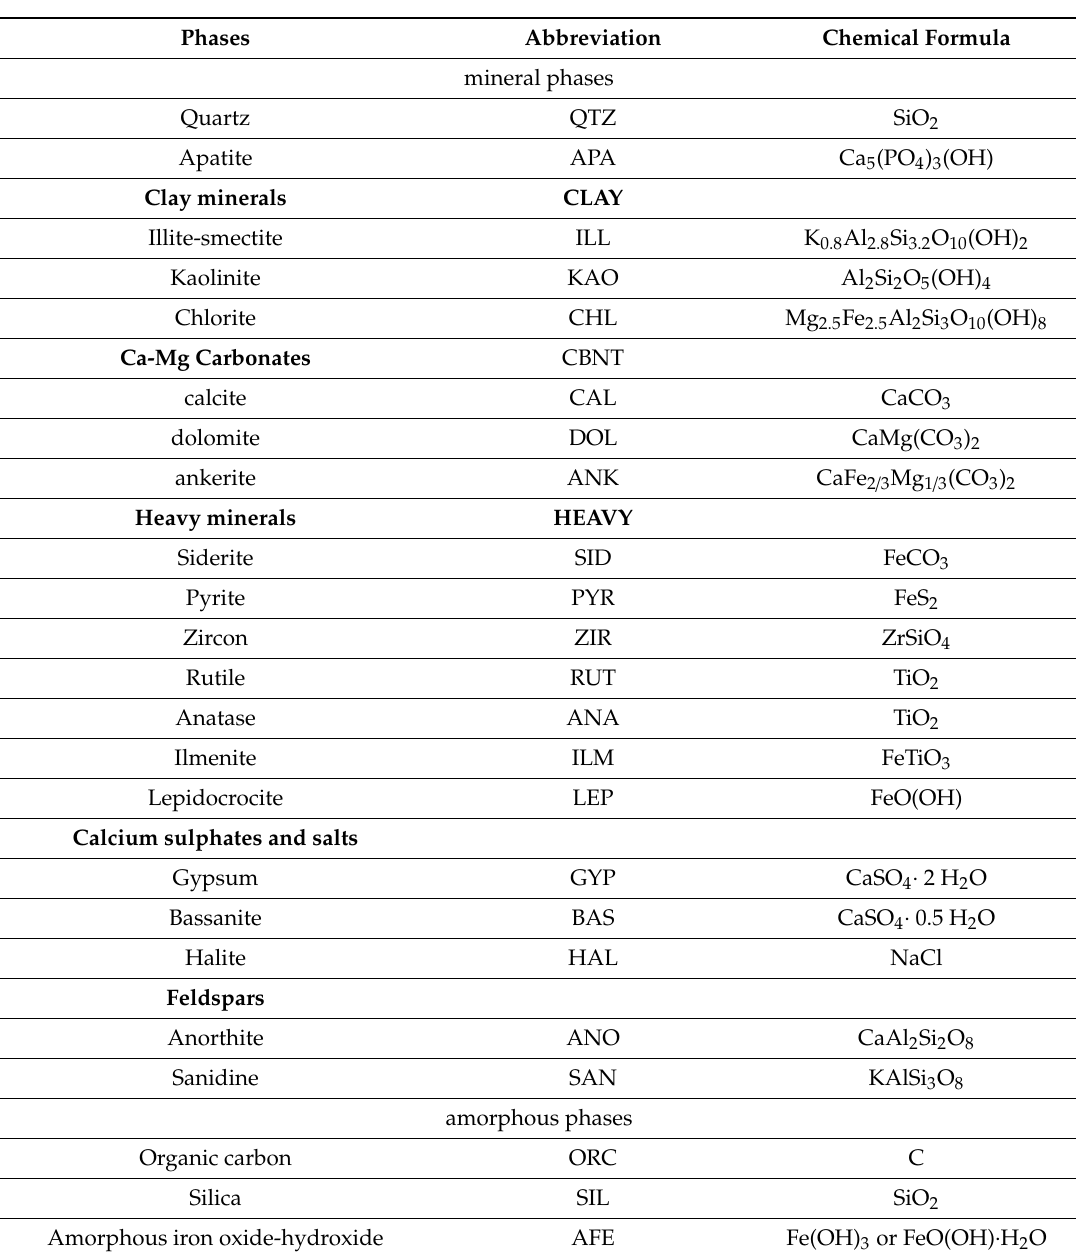
Table 1. List of mineral and amorphous phases included for determination of mineralogical composition using SVD-QPA methodology [25,35,36]. The term “amorphous” refers to poorly-crystalline or finely-dispersed phases not discernable in XRD powder patterns. As illite-smectite interstratification is known to occur in oil sands [33], we then identify the corresponding phase as “illite-smectite”; however, not knowing its chemical formulae, we assumed here a pure illite nominal stoichiometry for performing quantitative phase